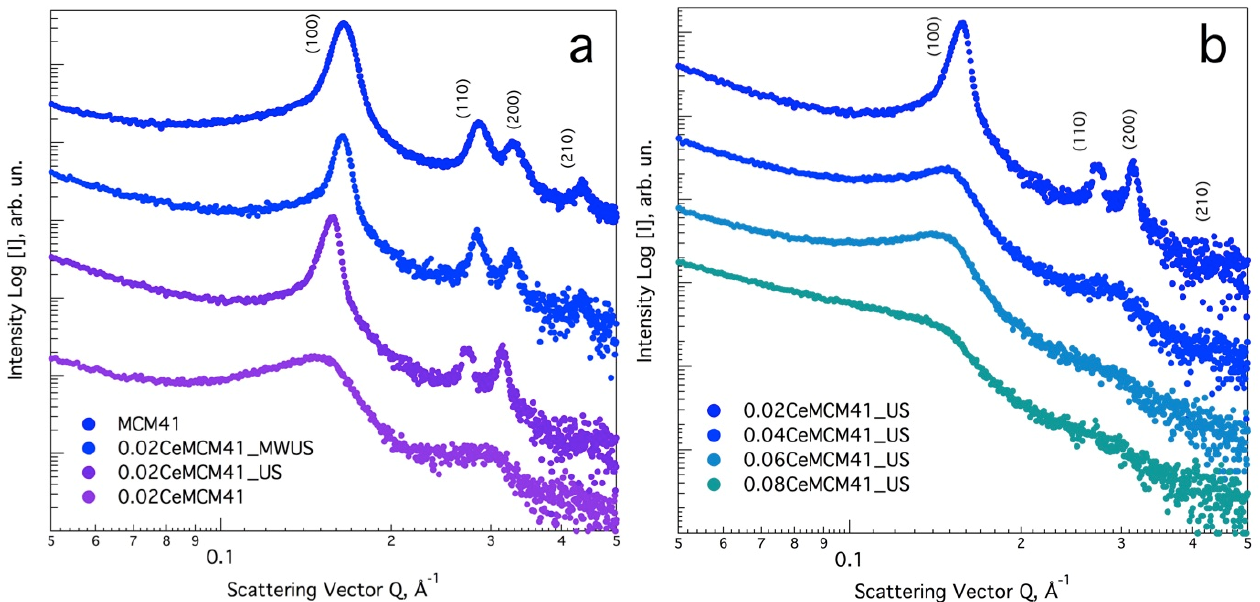
Figure 1. Small Angle X-ray Scattering curves for ( a ) MCM-41 and Ce-modified MCM-41 (Ce/Si molar ratio = 0.02) prepared using US, MW irradiation and conventional magnetic stirring (0.02Ce- MCM-41); ( b ) SAXS curves for Ce-modified silica with ranging Ce/Si molar ratios. Table 1. Lattice cell parameters for Ce-modified mesoporous silica